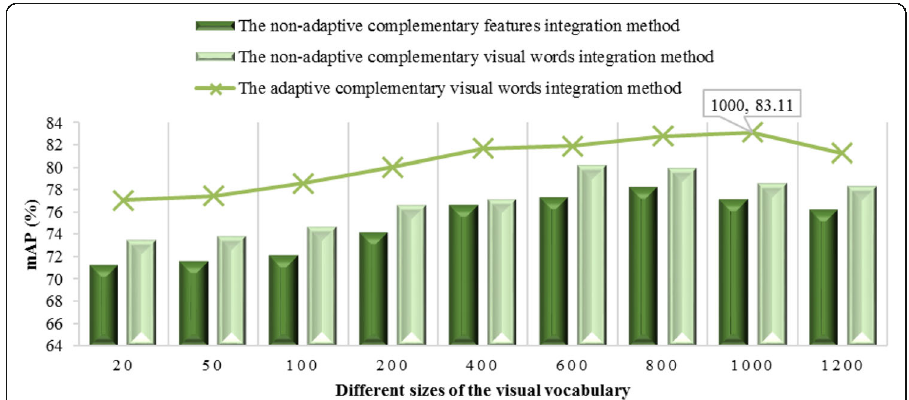
Fig. 14 Comparison of mAP of the proposed method with competitive CBIR methods on the Scene 15 image